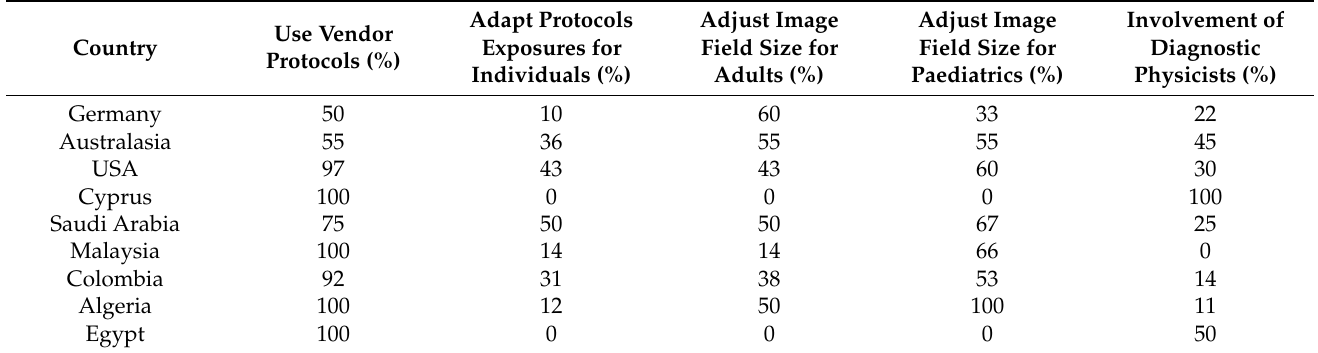
Table 3. Percentages of radiotherapy centres in each country adapting protocols for individual patients and involvement of diagnostic medical physicists in optimization